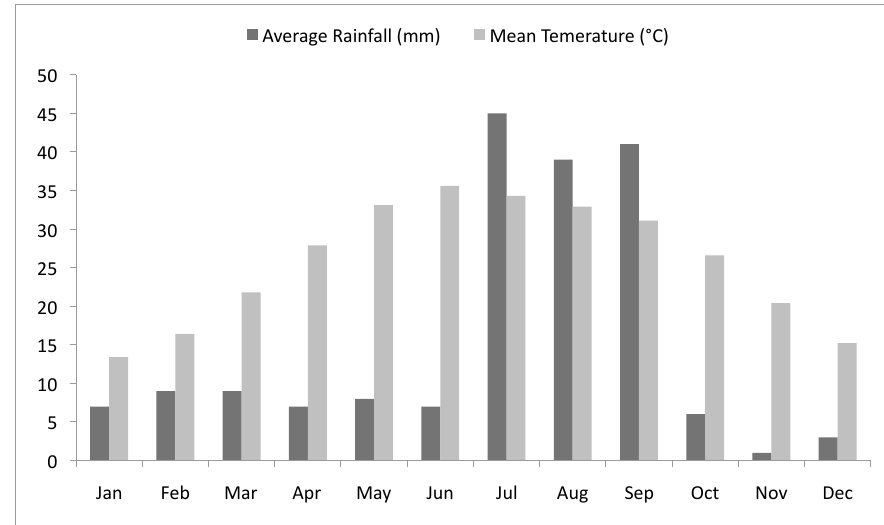
Fig. 1: Mean annual temperature and rainfall data of Cholistan desert, District Bahawalpur 362